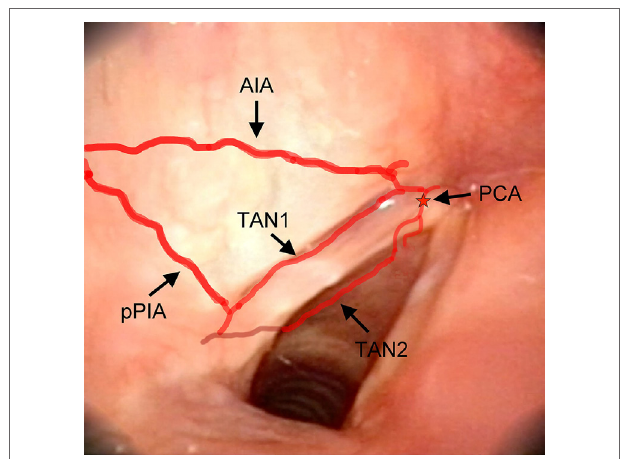
Figure 8 | Laryngeal videoendoscopy, more closely focusing on the glottic plane. Abbreviations: AIA, antero-inferior artery; pPIA, posterior branch of the postero-inferior artery; TAN1, lateral transverse anastomotic network; TAN2, medial transverse anastomotic network; red star, endolaryngeal emergence of the PCA, paracommissural branch of the crico–thyroid